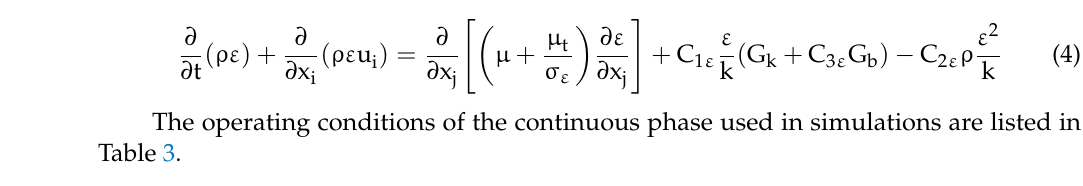
Table 3. Operating conditions of ammonia